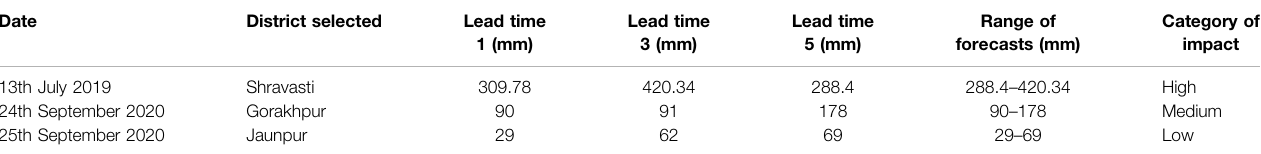
TABLE 2 | Details about the three dates of extreme rainfall forecast, districts selected and category of expected